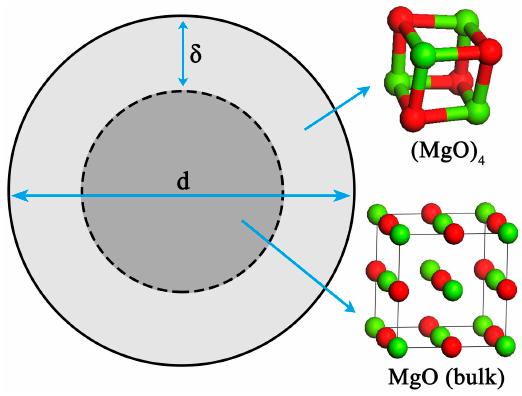
Figure 1. Structure of nano-MgO.